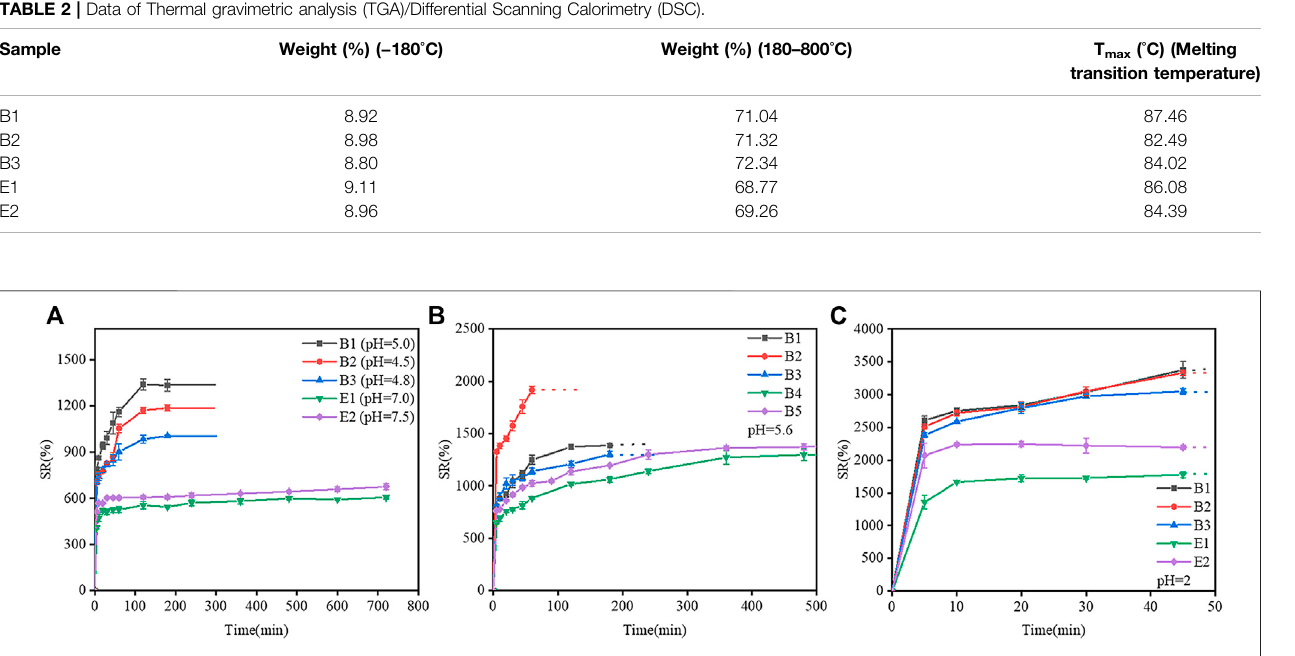
FIGURE 4 | Swelling curve of different gelatin fi lms. (A) At the pH of the gelatin fi lms isoelectric point, (B) At pH 5.6, (C) At pH 2 (the dashed lines indicate the samples dissolved in the water and cannot be observed).